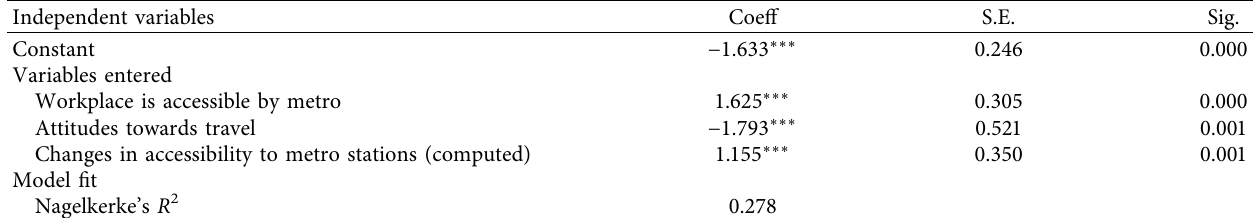
Table 6: Logistic regression analysis results related to changes in private car users’ travel behaviour. Independent